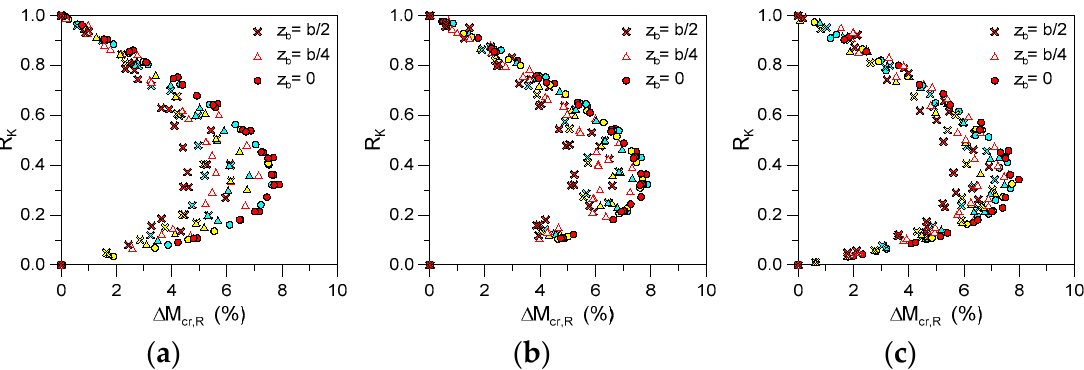
Figure 17. Percentage scatter (Equation (28)) for critical buckling moment estimates of selected LR glass beams ( n b = 1, K = var) grouped by span: ( a ) L = 2000 mm, ( b ) L = 3000 mm, and ( c ) L = 4000 mm (with t = 20, 30, 40 mm and b = 100, 200, 300 mm).